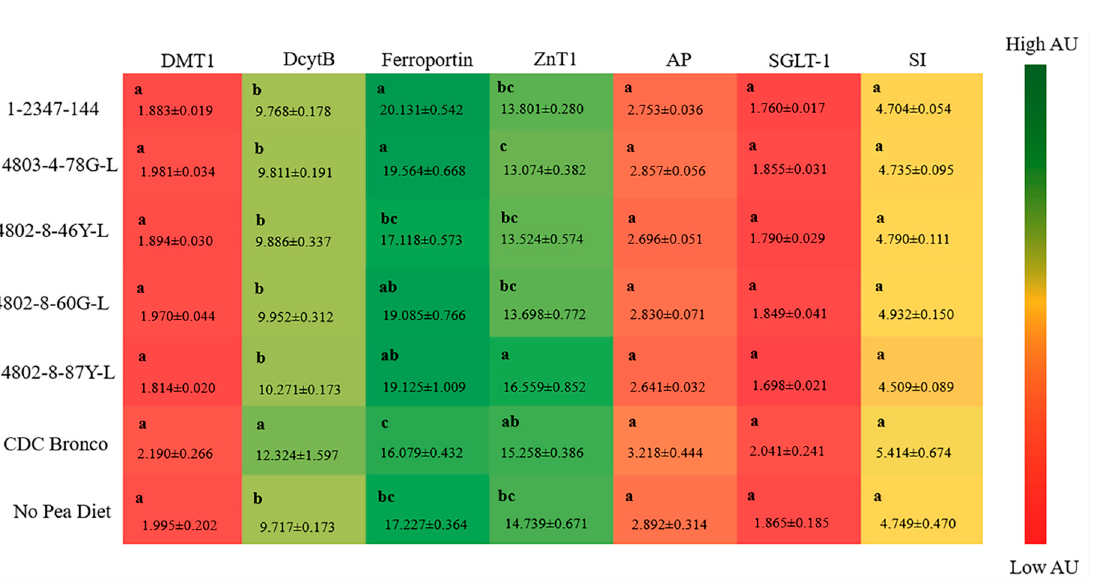
Figure 2. Gene expression of iron proteins in the duodenum after six weeks of consuming pea-based diets. Values are means ± SEM ( n = 10 per treatment group). a–c Treatment groups not indicated by the same letter are significantly different ( p < 0.05). DMT-1, divalent metal transporter-1; DcytB, duodenal cytochrome b; ZnT1, zinc transporter 1; AP, amino peptidase; SGLT-1, sodium-glucose transporter 1; SI, sucrose isomaltase.